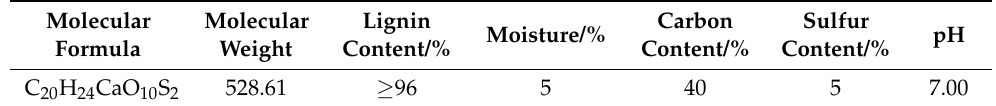
Figure 2. Microstructure of CLS.